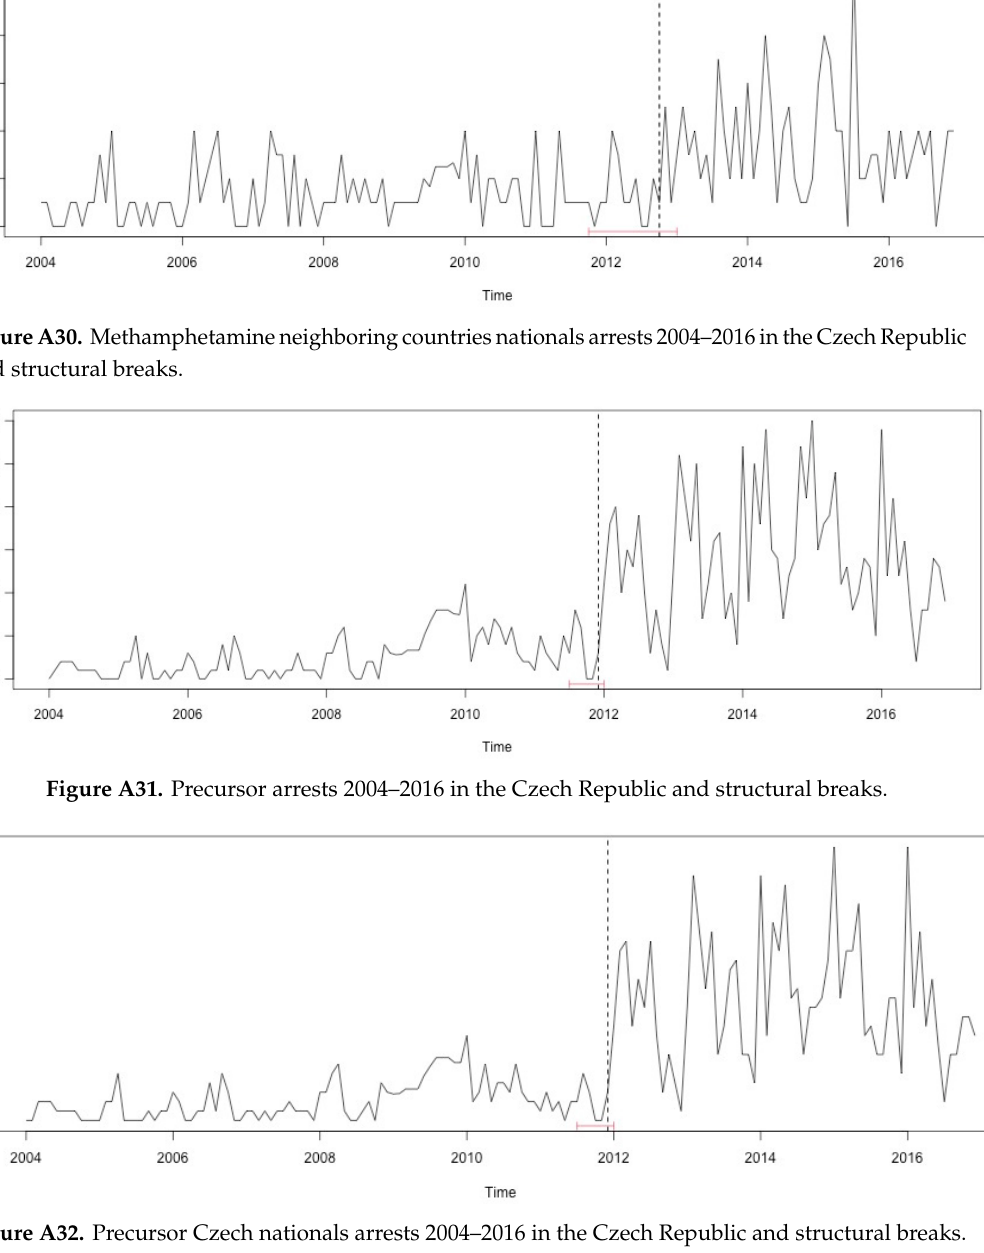
Figure A32. Precursor Czech nationals arrests 2004–2016 in the Czech Republic and structural breaks.